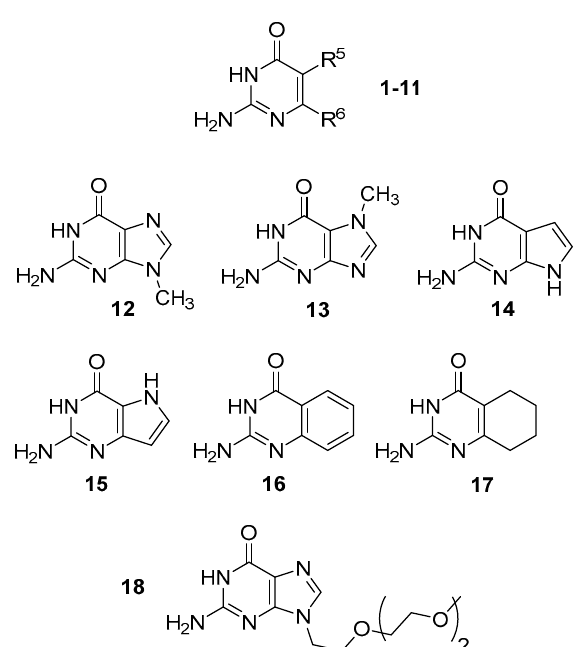
Figure 2. The structure of compounds 1 – 18 .